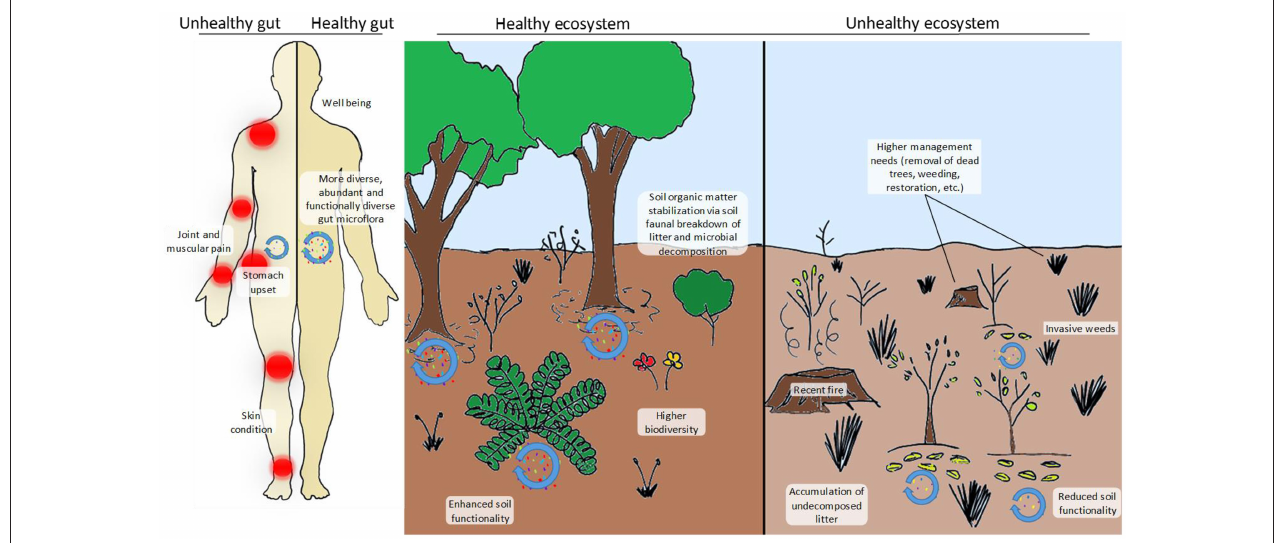
FIGURE 1 | Comparison between a healthy and an unhealthy gut (left-hand side panel) and a healthy and an unhealthy ecosystem (right-hand side panel). In the case of the human individual, his/her gut microbiota is less diverse (“red” microbes are completely absent), less abundant and contains more pathogenic taxa (“yellow” microbes). The individual with the healthy gut has a more functional and more abundant microbiota that provides him/her with essential nutrients, hormones, amino acids, etc. and stimulates his/her immune system. A healthy gut is also less prone to become infected by pathogens and can process toxic compounds (i.e., detoxify) more easily. The disturbed (i.e., unhealthy) ecosystem shown here has recently been affected by a devastating fire fuelled by the accumulation of N-loving exotic grasses that have altered the natural fire dynamics of the system. Facilitated by the altered fire dynamics, the system has also become chronically dominated by weedy grasses, therefore requiring intensive (and costly) management practices (dead tree removal, weeding and restoration), also posing a threat to nearby human populations and their properties. Biodiversity (in terms of microbial, faunal and plant communities) is remarkably higher in the healthy ecosystem, which also has a higher potential to process organic matter inputs and stabilize them in the long-term soil pool. In contrast, undecomposed or partially decomposed litter accumulates on the functionally impoverished soil of the unhealthy ecosystem. This pattern is in agreement with reported observations of higher soil carbon sequestration under increased nitrogen deposition scenarios due to the inhibition of soil enzymes and the reduction of microbial biomass but poses relevant questions such as: Is this type of N deposition-induced carbon sequestration desirable? And, does it really represent a long-term (or even short-term)